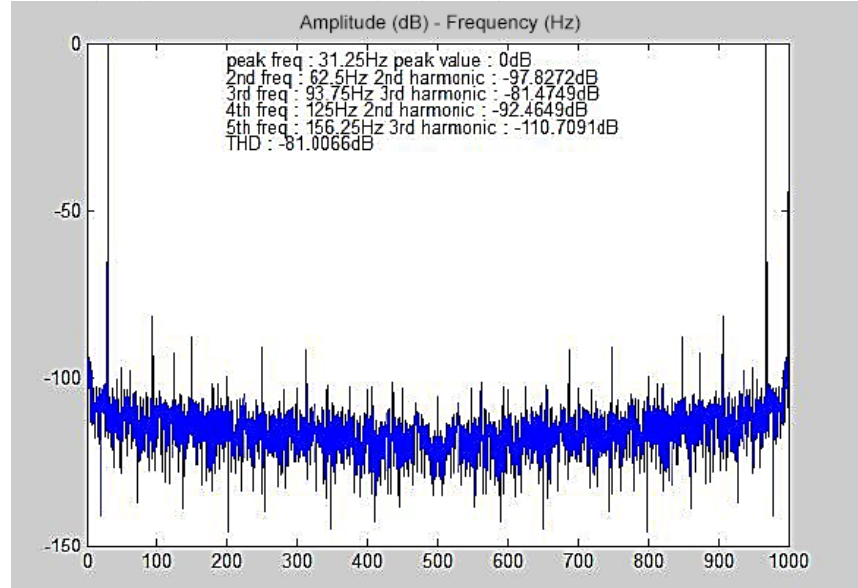
Figure 9. Harmonic distortion test chart.